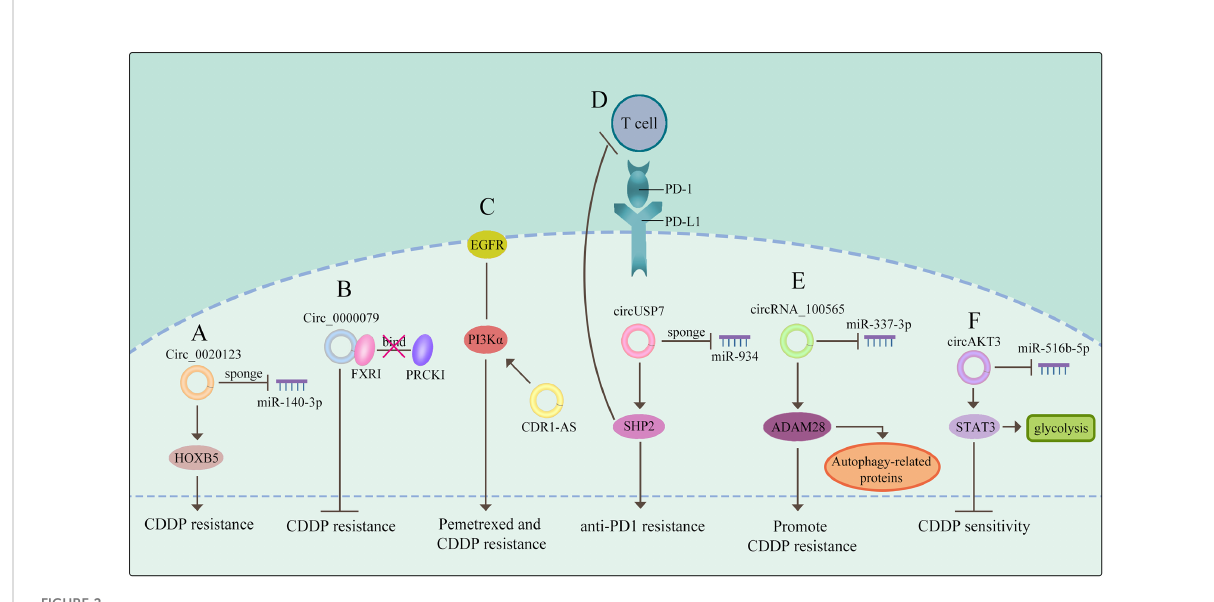
FIGURE 2 CircRNAs mediate drug resistance of NSCLC (A) circRNAs function as miRNA sponges to mediate drug resistance. (B) circRNAs govern drug sensitivity as the sponges of RBPs. (C) circRNAs mediate drug resistance through a signaling pathway. (D) circRNAs control drug resistance by inhibiting T cells. (E) circRNAs regulate autophagy derived proteins to mediate drug resistance. (F) circRNAs control drug resistance by curbing glycolysis. The meaning of " → " is "promote", and "T" is